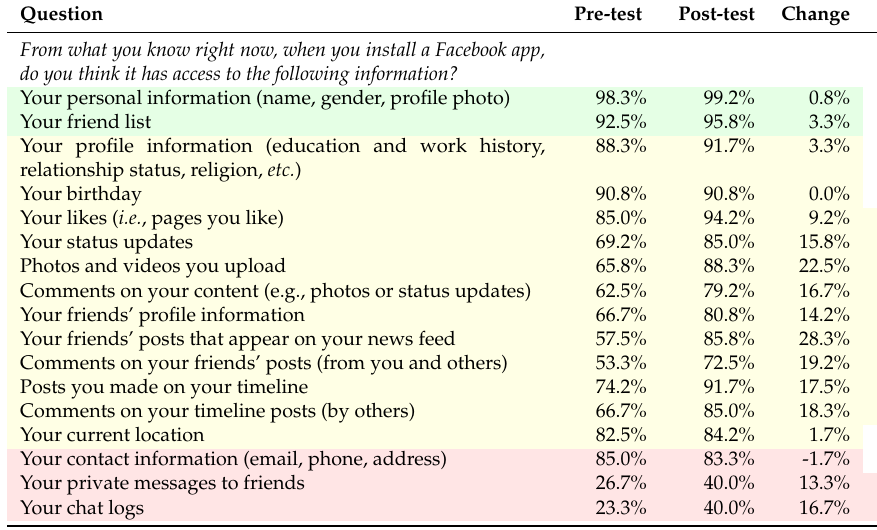
Table 3. Fact-based questions about information Facebook apps can access. The percentage of “yes” responses are shown. Significant increases are marked * for p < 0.05 and ** for p <